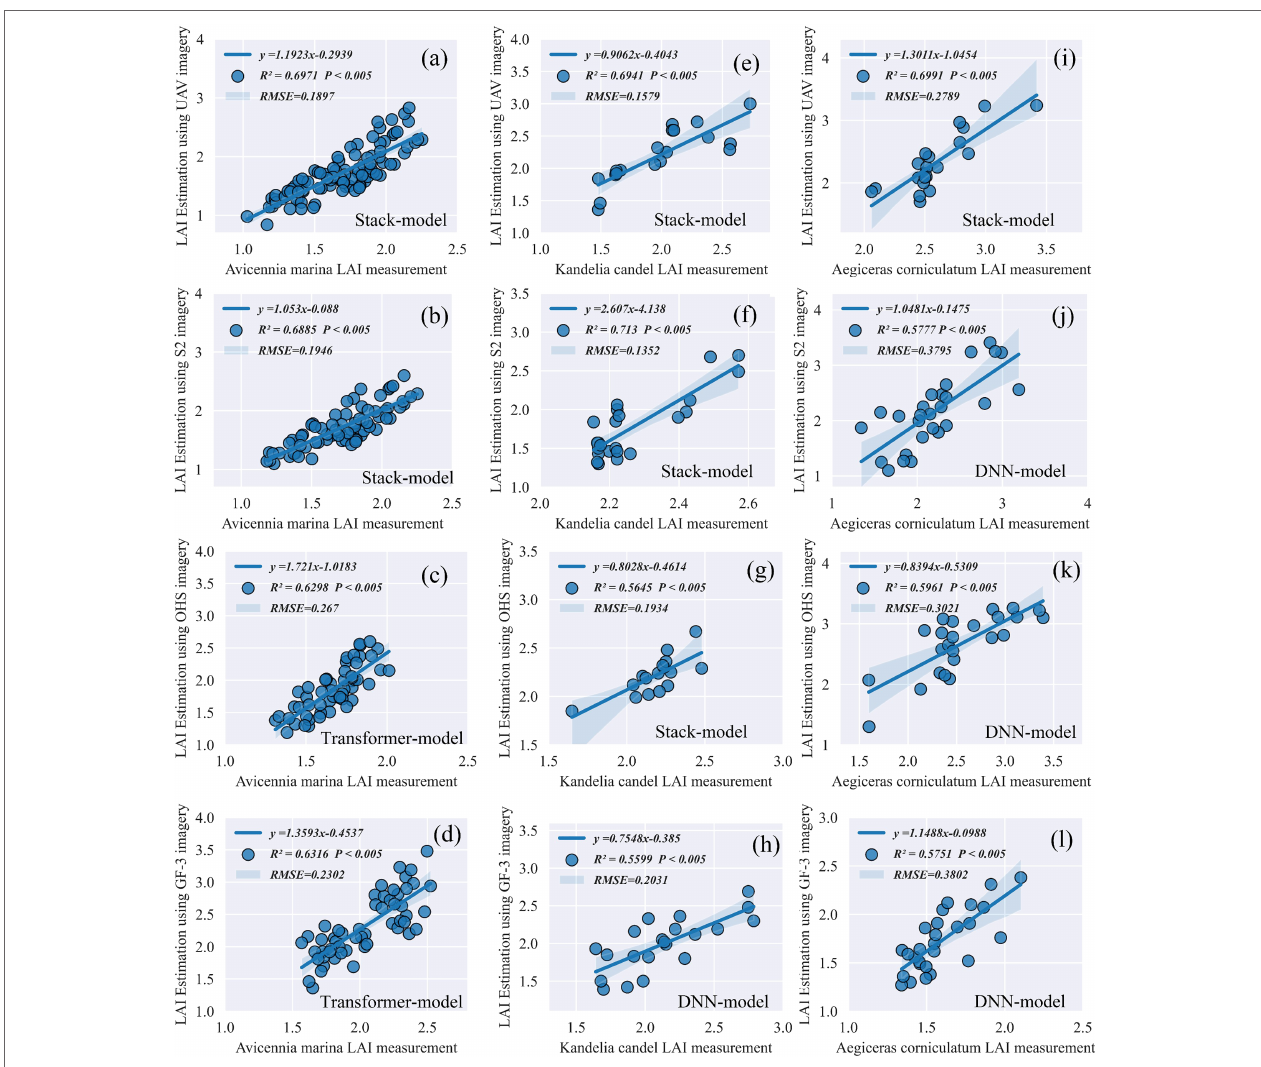
FIGURE 7 | Comparative analysis of estimation accuracy of the LAI for mangrove communities between the ELR and DLR models. The P-value represents the significant difference between the estimated and measured LAI values of mangrove communities. (A–L) Represent the LAI estimation accuracy (R2 and RMSE) of the optimal model for 'Avicennia marina', 'Kandelia candel' and 'Aegiceras corniculatum' under the 4 image data,